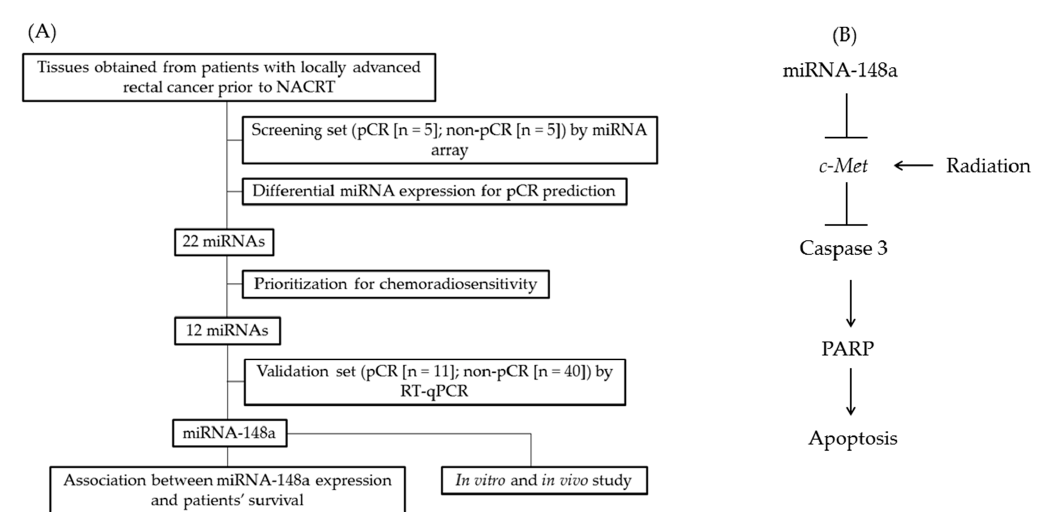
Figure 1. The study design and hypothesis. ( A ) The design of identification of the candidate miRNA. ( B ) The potential regulatory pathway of miRNA ‐ 148a.